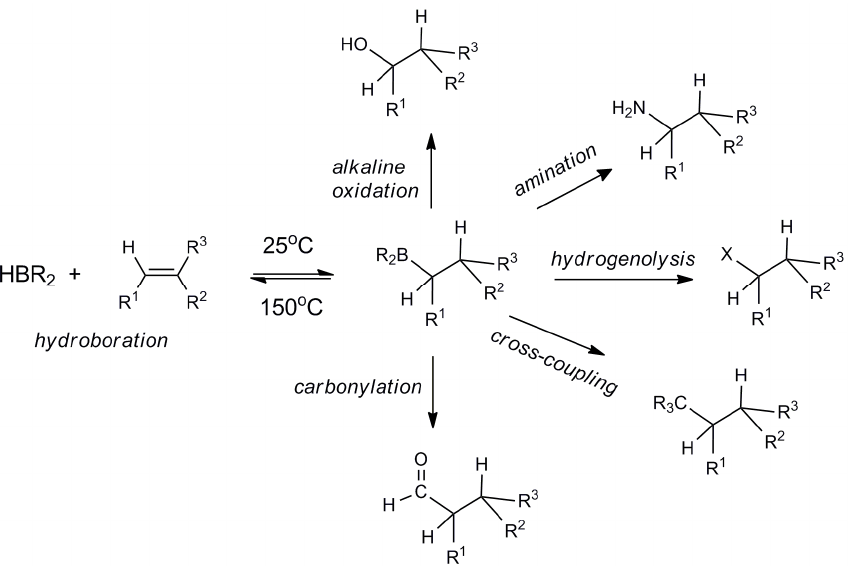
Figure 1. Hydroboration of alkenes and subsequent transformation to generate a wide array of